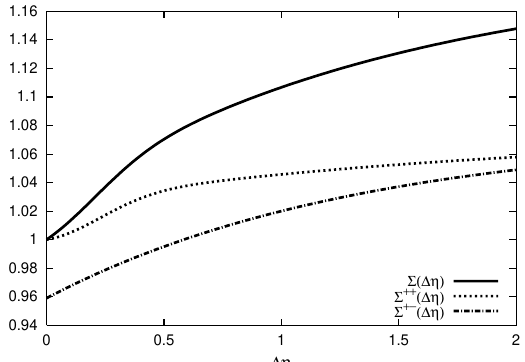
, n + ) ≡ Σ ++ ( ∆ η ) (dotted line) and F B , n ) ≡ Σ ( ∆ η ) for the full multiplicities in these F B